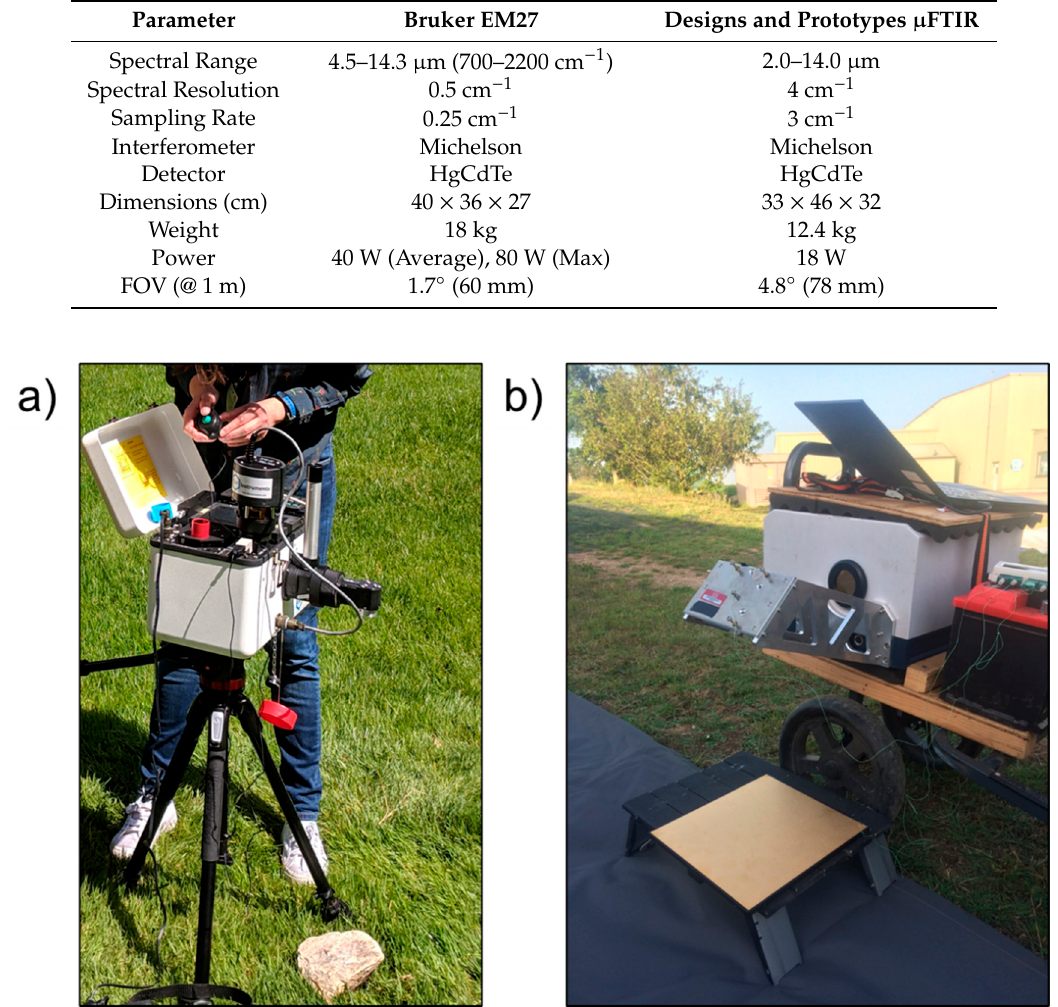
Figure 2. ( a ) Field-deployed Designs and Prototypes μ FTIR spectrometer and ( b ) field-deployed Bruker EM27 FTIR spectrometer with a 45° mirror attachment fitted to view upwelling radiation from the surface, here shown assessing downwelling LWIR atmospheric radiation via observations of an Infragold panel.